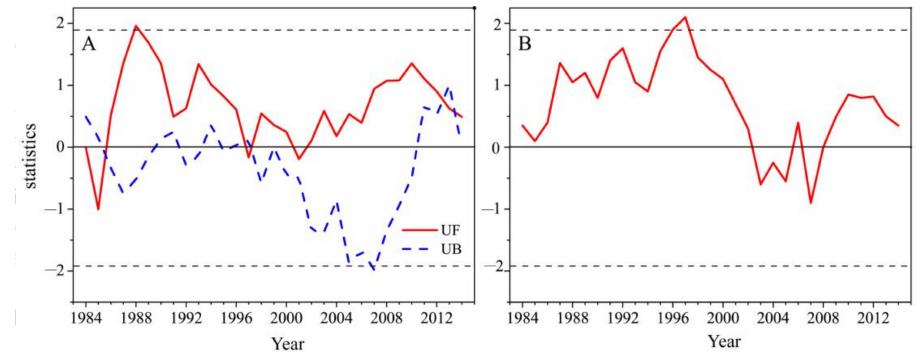
Figure 7. The time series from sequential Mann–Kendall statistics ( A ) and moving t -test ( B ) of mean annual precipitation of 25 stations from 1984–2014. UF and UB indicate the progressive and retrograde curve, respectively. Horizontal dashed lines denote the confidence at level of